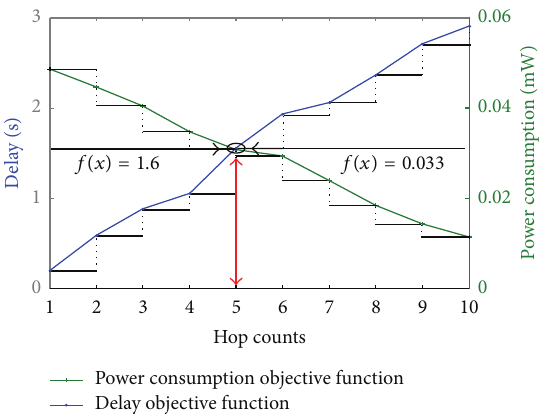
Figure 7: Adopting the objective function with the level cut method for the single-path routing